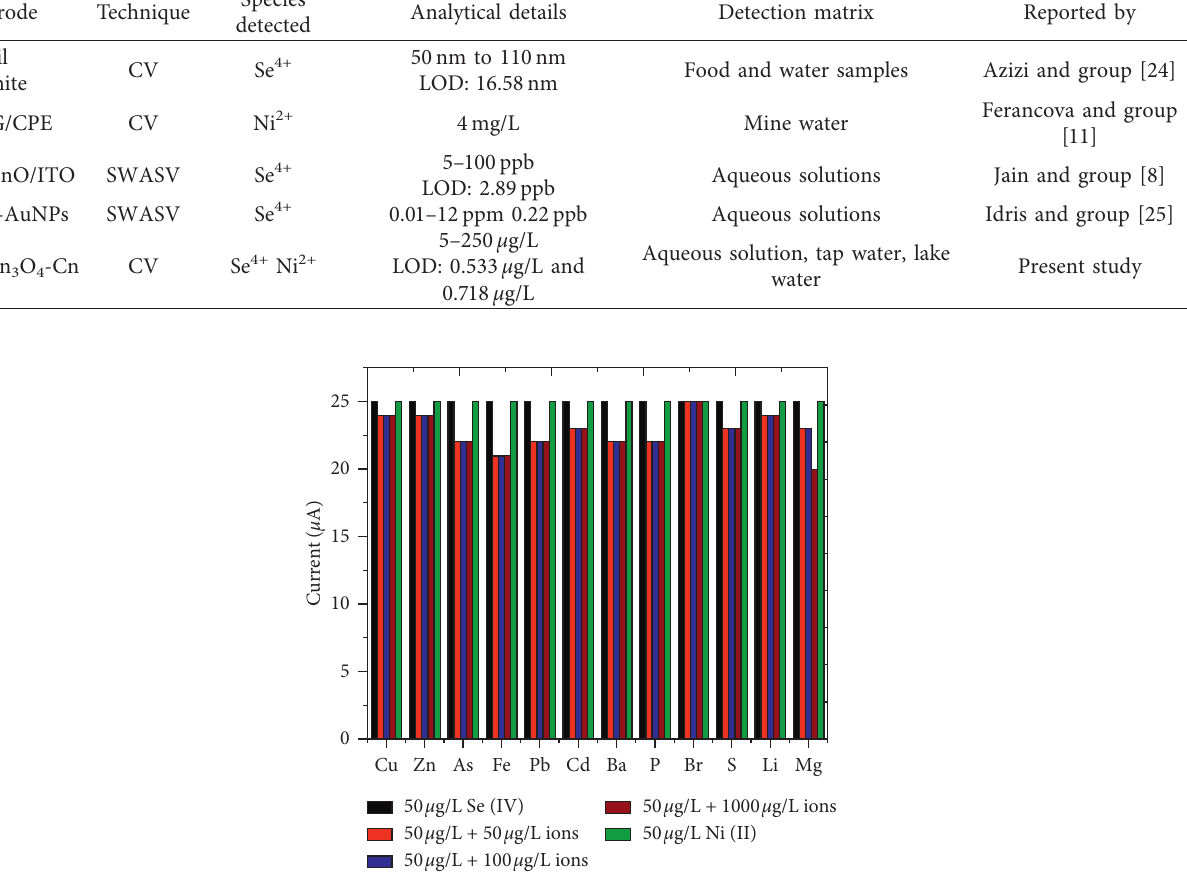
Figure 8: Comparative voltammogram response of Mn 3 O 4 -Cn electrode to 50 µ g/L of Se (IV) and Ni (II) in 0.1M PBS and 5mM Fe(CN) 6 in the presence of common interfering ions (10 µ g/L each) at 25 °